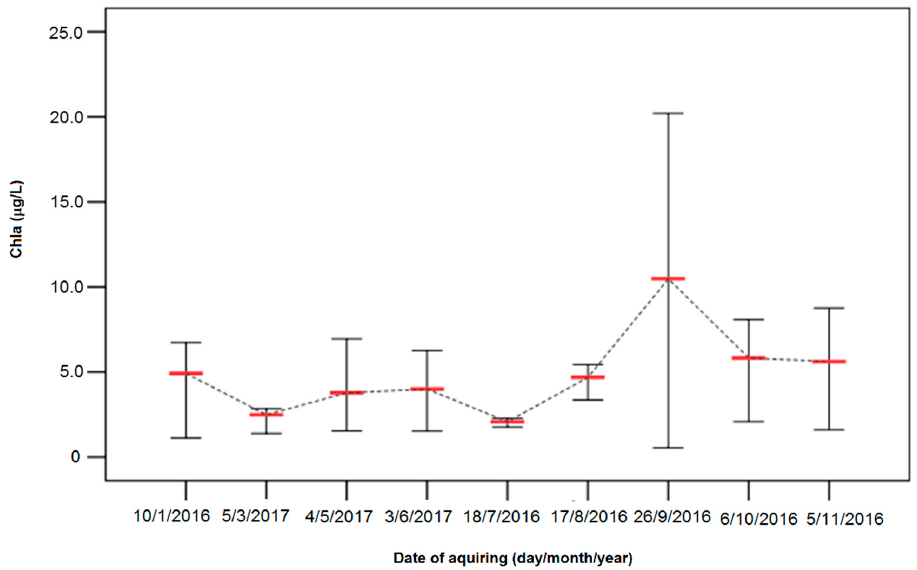
Figure 8. Temporal change in minimum, mean, and maximum values of Chla in Lake Ba Be water estimated from clear pixels of eleven S2A images by assuming that the Chla estimated in the same month all follow the same general trend in the image acquisition years 2015 to 2017. Estimated Chla has low correlations with local monthly average temperatures and precipitation ( R = 0.13 and − 0.10, respectively) because the Chla estimated from small number of available S2A